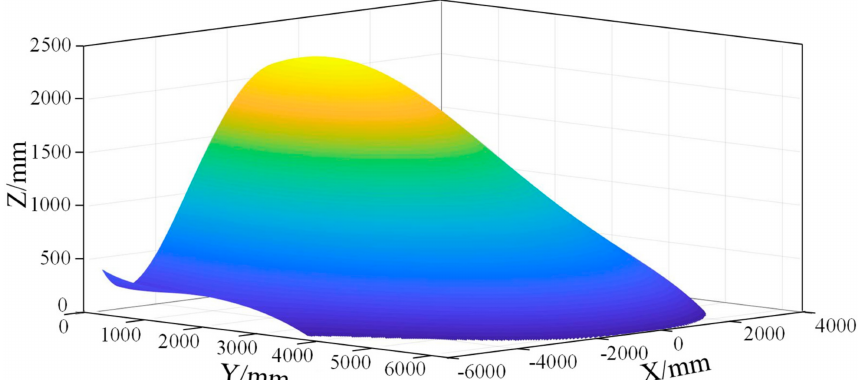
Figure 7. The polynomial surface fitting results of the sandpile surface.